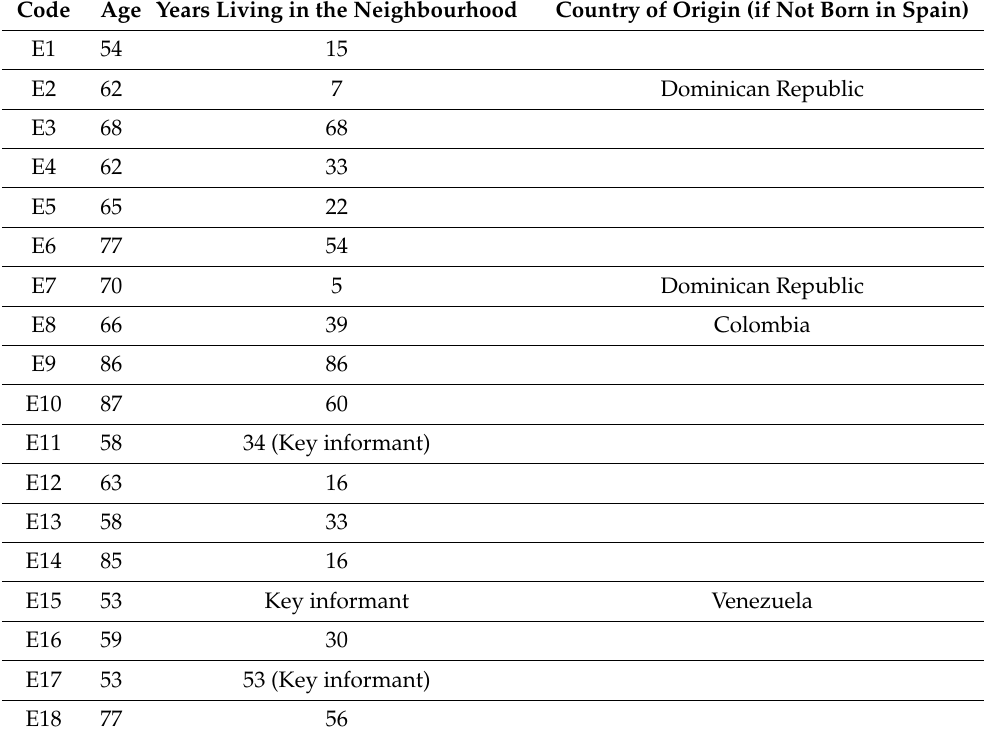
Table 2. Qualitative interviews